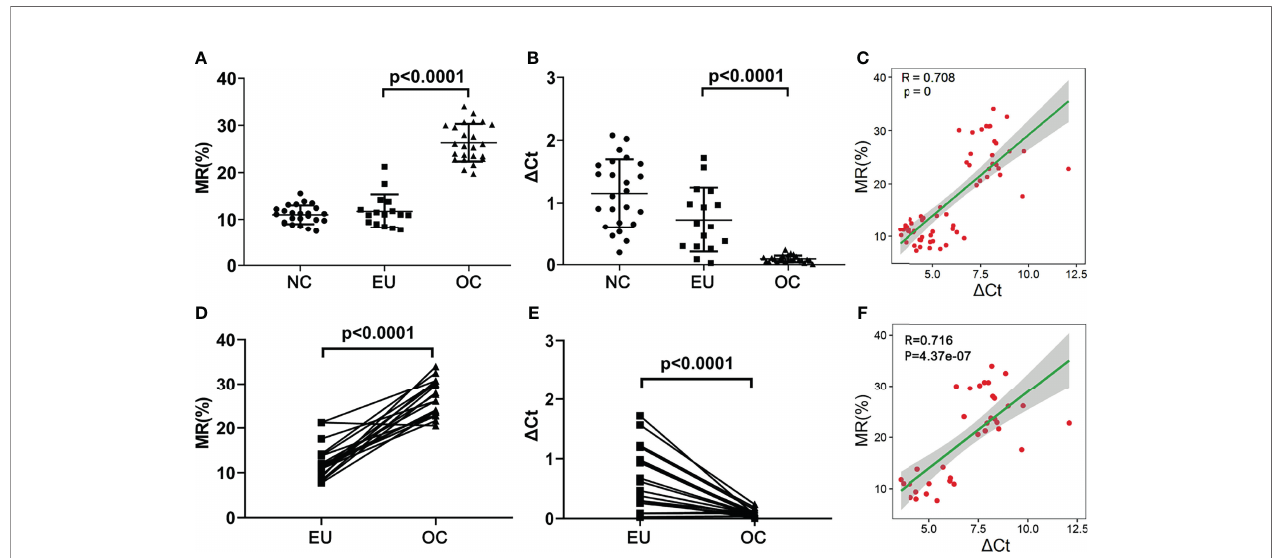
FIGURE 7 | The MRs and mRNA expression of HOXA10 in NC, EU and OC. (A) The MRs of representative CpGs detected by ddPCR. (B) The mRNA expression of HOXA10 in EU and OC. (C) The correlation between MRs and HOXA10 mRNA expression. (D) The comparisons of MR in EU and OC from the same patients. (E) The comparisons of HOXA10 mRNA expression in EU and OC from the same patients. (F) The correlation between MRs and HOXA10 mRNA expressions in EU and OC from the same patients (MR, methylation rate; EU, eutopic endometrial tissues; OC, ovarian cyst; NC, normal